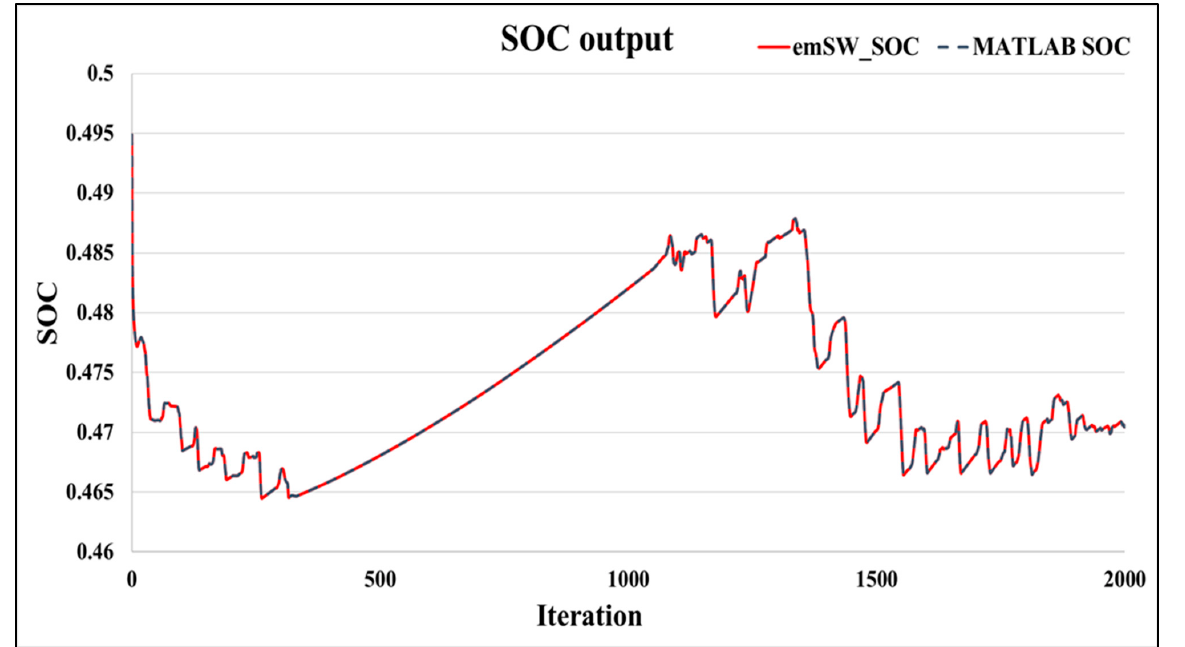
Figure 5. SOC output: proposed embedded software vs. baseline Matlab.